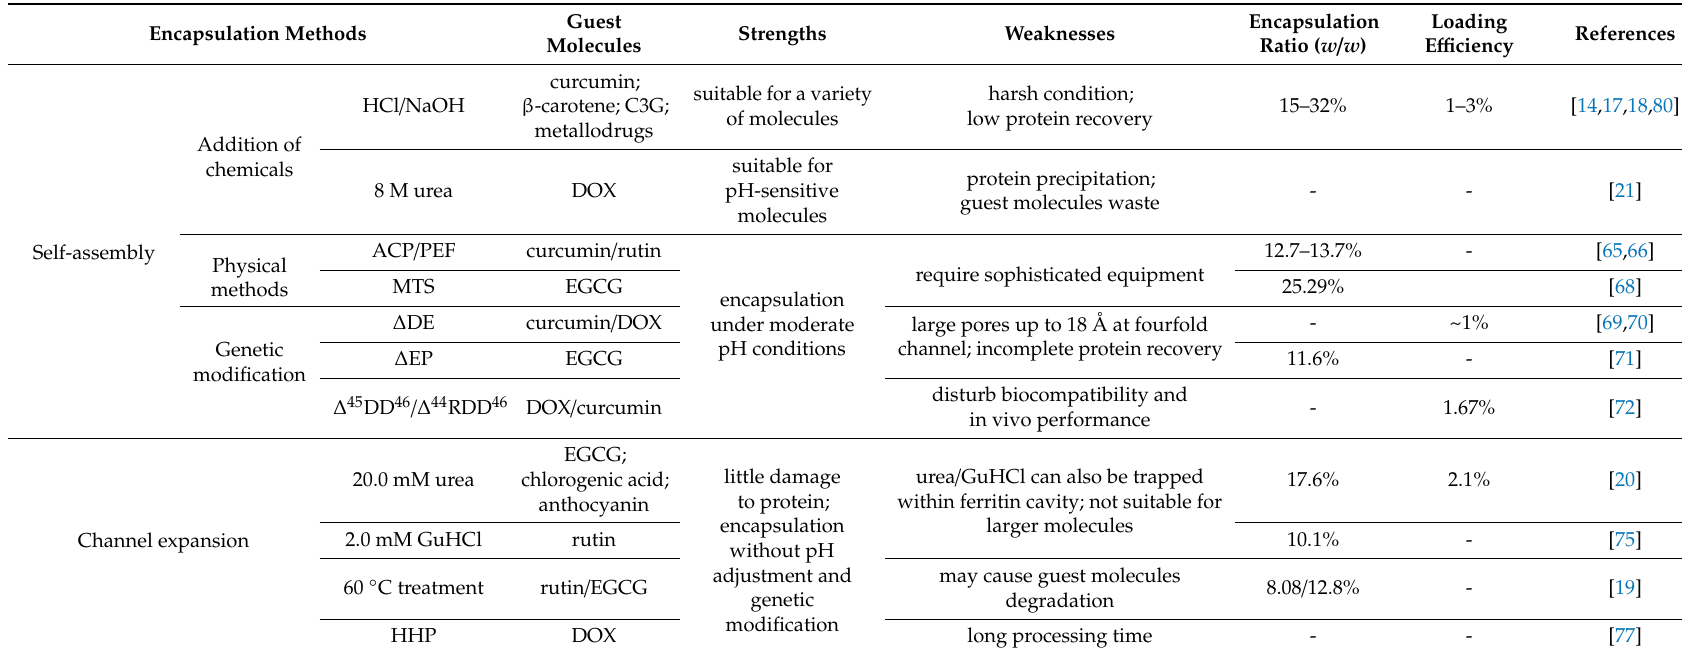
Table 1. Various encapsulation methods for bioactive molecules based on ferritin nanocage. ACP, atmospheric cold plasma; PEF, pulsed electric field; MTS, manothermosonication; EP, extension peptide; HHP, high hydrostatic pressure; DOX, doxorubicin; EGCG, epigallocatechin